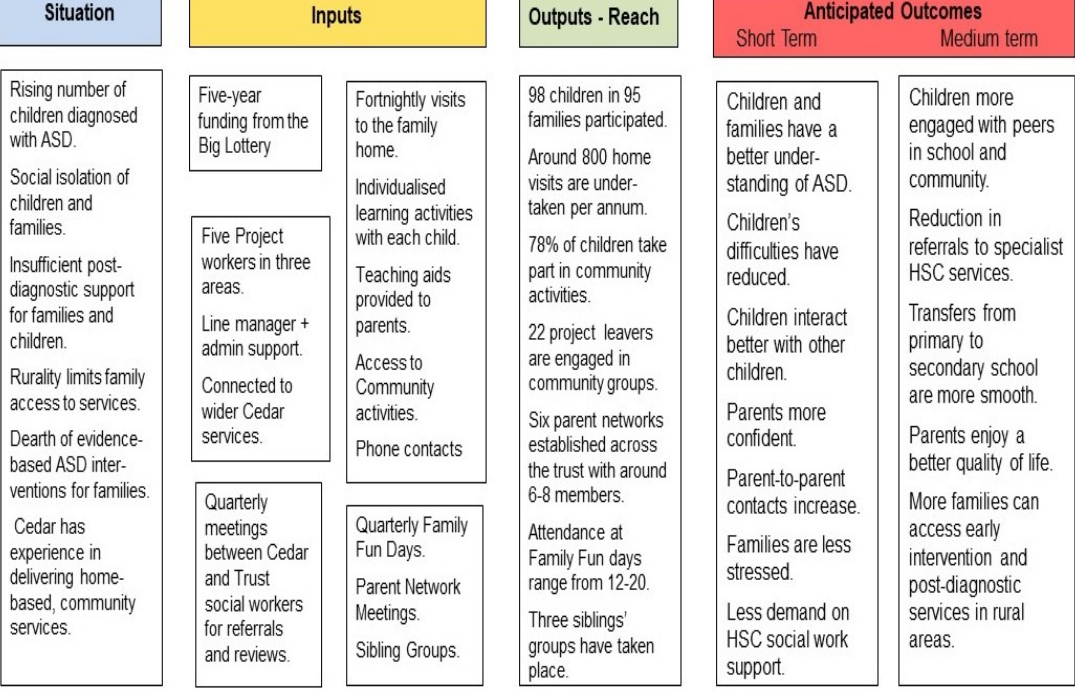
Figure 1. The logic model for the family-centred intervention.